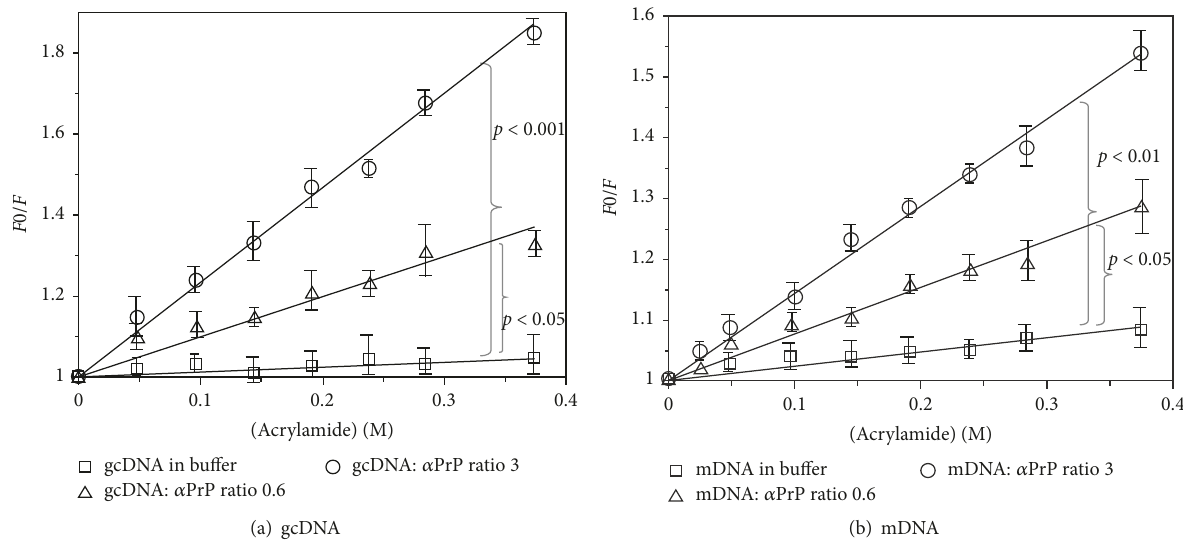
Figure 10: Assess the accessibility of interchelated YOYO as the extent of DNA condensation. Stern-Volmer plots of acrylamide quenching of YOYO bound to gcDNA (a) and mDNA (b) in the presence of different concentrations of 𝛼 -PrP in Hepes buffer, pH 7.4 containing 100mM NaCl. Concentrations of the DNAs in phosphates were 10 𝜇 M and the dye concentrations were 5nM in both the experiments (dye to DNA- phosphate1 :2000). 𝐹 0 and 𝐹 arethefluorescenceintensitiesofthedyeinbufferandinthepresenceofincreasingconcentrationsofacrylamide. ◻ , △ , and I in the figures are the fluorescence quenching results in buffer and in the presence of PrP:DNA ratios of 0.6 and 3, respectively. Five individual titration experiments were performed and the average was plotted against acrylamide concentration. The statistical data were calculated with Student’s 𝑡